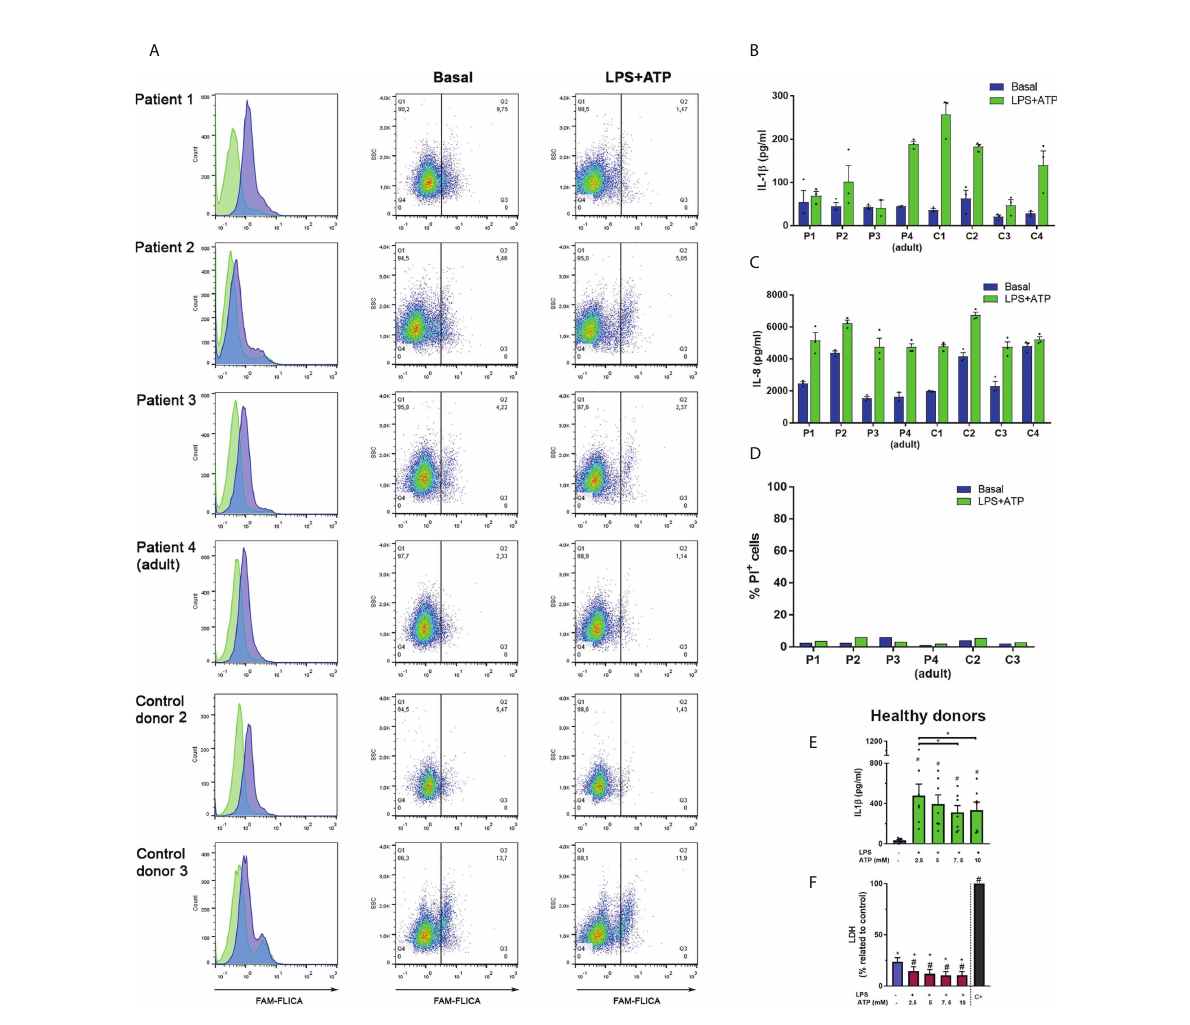
FIGURE 5 Responses of neutrophils isolated from patients who are carriers of the GOF NLRP3 c.1322C>T (p.A441V) mutation. (A) Neutrophils from patients and aged-matched control donors were stimulated or not with LPS (t= 0) and 2 h later were stimulated or not with ATP. Ten min later, the FLICA probe was added, and cell fl uorescence was determined at 2 h 40 min by fl ow cytometry. Data are depicted as histograms (blue, basal -unstimulated- condition; green, LPS+ATP-stimulated cells) to appreciate FLICA signal reduction upon stimulation; and dot plots, to show the % of cells with FLICA signal higher than the same arbitrary threshold set for all donors. (B – D) Neutrophils from patients and aged-matched control donors were stimulated or not with LPS (t= 0) and 2 h later were stimulated or not with ATP. At 5 h post-LPS stimulation IL-1 b (B) or IL-8 (C) concentrations in culture supernatants were determined by ELISA and PI incorporation in the cell pellets was evaluated by fl ow cytometry (D) . In (B) and (C) , each bar represents the mean+SEM of the cytokine concentrations of an individual donor evaluated in triplicate. (E , F) Neutrophils from healthy donors were treated or not with LPS, and 2 h later with the indicated ATP concentrations. At 5 h post-LPS stimulation IL-1 b (E) or LDH activity (F) were determined. Two-way ANOVA followed by Tukey ’ s multiple comparisons test. # and *p < 0.05. # vs basal (E, F) ; * vs positive control (F)